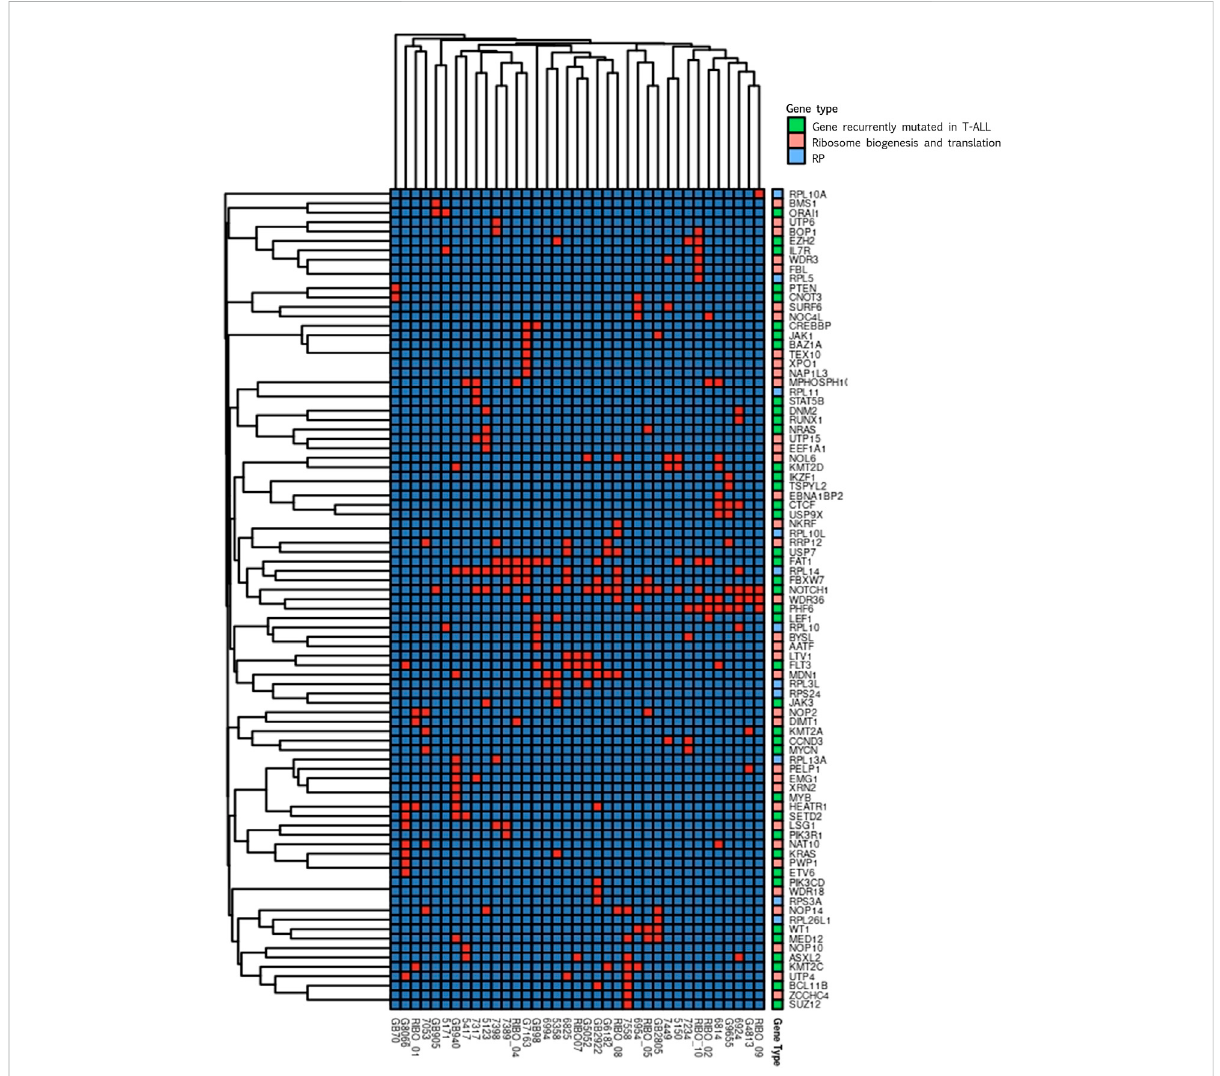
FIGURE 3 Clustering analysis. Cluster heatmap of variations detected in genes encoding for proteins involved in ribosome biogenesis and translation (pink), for ribosomal proteins (RP, light blue) and in genes recurrently mutated in T-ALL (green). In the graphs only genes harbouring variations in at least one patient are represented. Columns represent single patients; rows represent single genes. The order of both the patients and the genes is based on hierarchical clustering with the Jaccard distance. Presence of gene ’ s variation is indicated in red and the absence in